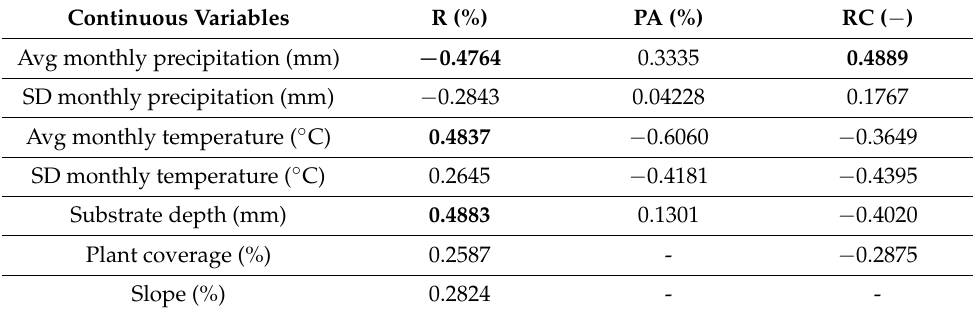
Table 7. Spearman’s rank-order correlation test